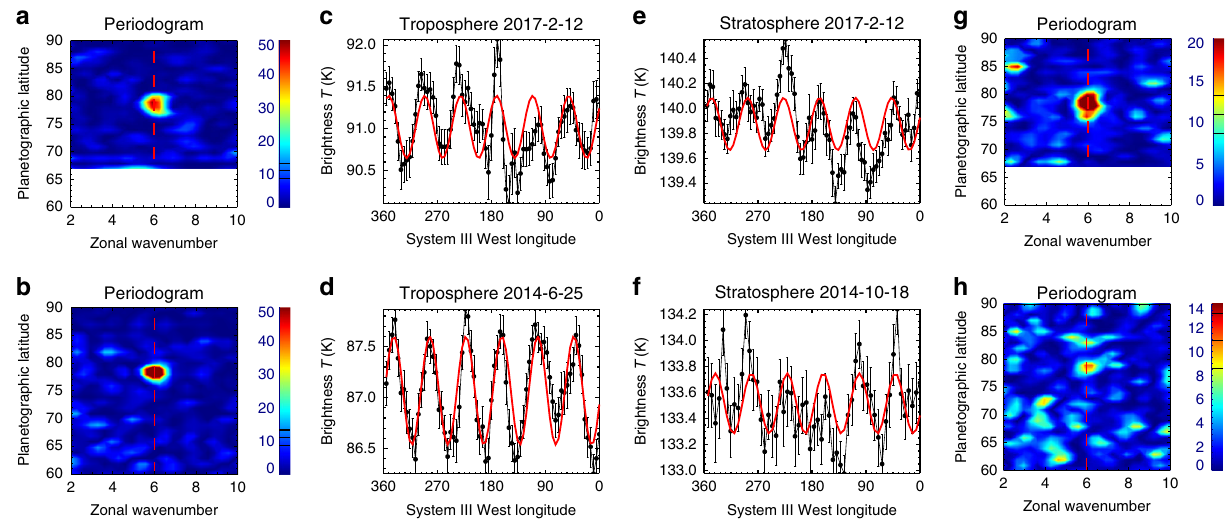
Fig. 2 Detection of the hexagon in the troposphere and stratosphere. c – f show brightness temperatures and their uncertainties in the troposphere ( c , d , averaged over 600 – 620 cm − 1 ) and stratosphere ( e , f , averaged over 1280 – 1320 cm − 1 ) extracted from 77 – 79°N in the June 25, 2014 and February 12, 2017 REGMAP observations, and the October 18, 2014 FIRMAP observation. As a guideline, a wavenumber-6 sinusoid has been fi tted to each observation (red curve), although the stratospheric map in 2014 is extremely noisy. a , b , g , h show the corresponding Lomb Scargle periodograms 5 , displayed as a function of latitude, showing the spectral power contained in each longitudinally resolved brightness temperature scan. Black lines on the colour bars represent false-alarm probabilities (from top to bottom) of 0.001, 0.01 and 0.1. A wavenumber-6 feature is clear in each data set near 78°N (vertical red dashed line), although the 2014 stratospheric hexagon is rather noisy (Fig. 1b). Using the sinusoidal fi ts, we detect a westward shift in the tropospheric hexagon vertices of 8.5 ± 1.1° over 963 days (the uncertainty comes from the quality of the sinusoidal fi t). Offsets between the tropospheric and stratospheric vertices